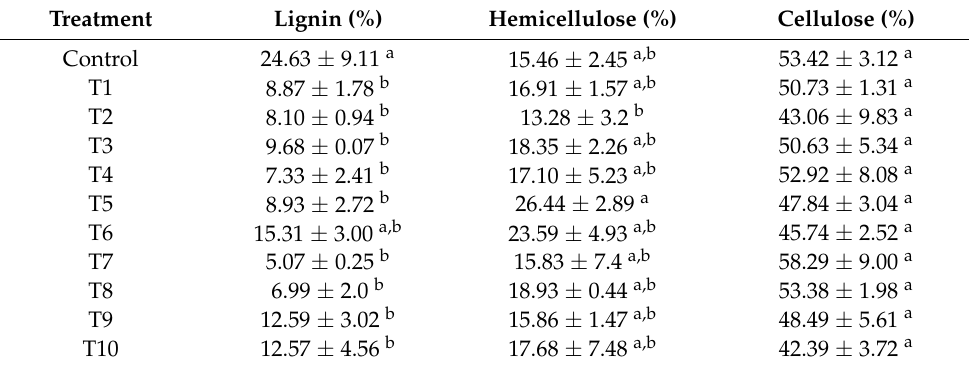
Table 3. Fibre fractions of substrates before cultivation. Treatment Lignin